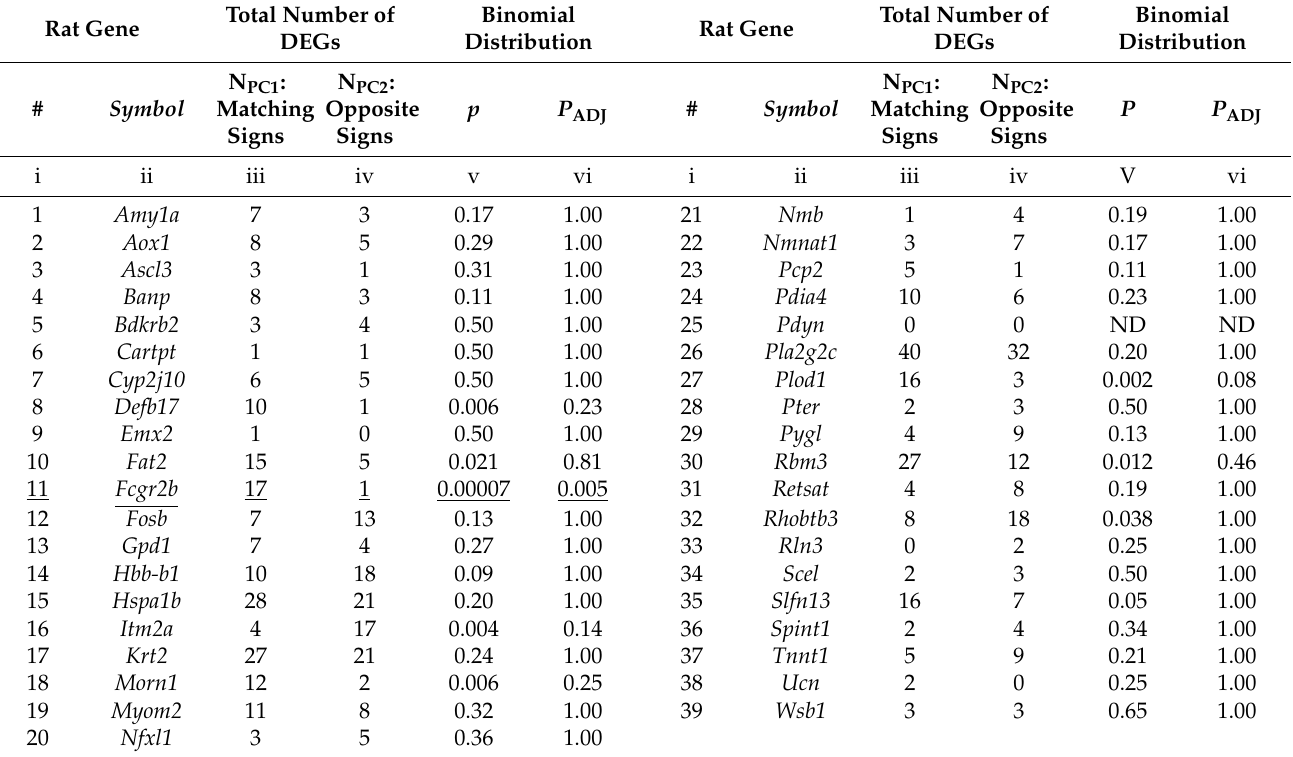
Table 6. Searching for ARD molecular genetic markers among human genes homologous to 39 novel PAG-related DEGs of the tame and aggressive rats. The number of these homologous DEGs linked to ARD susceptibility and ARD resistance in humans and animals is taken into